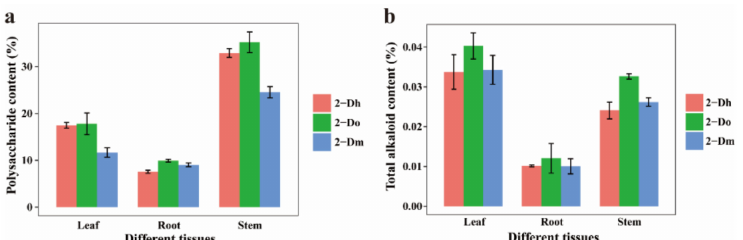
Figure 1. Polysaccharide and total alkaloid contents variation in di ff erent tissues of di ff erent species. ( a ) Polysaccharide content. ( b ) Total alkaloid content. There are three replicates of each sample. 2-Dh: two-year-old Dendrobium huoshanese , 2-Do: two-year-old Dendrobium o ffi cinale , 2-Dm: two-year-old Dendrobium moniliforme .